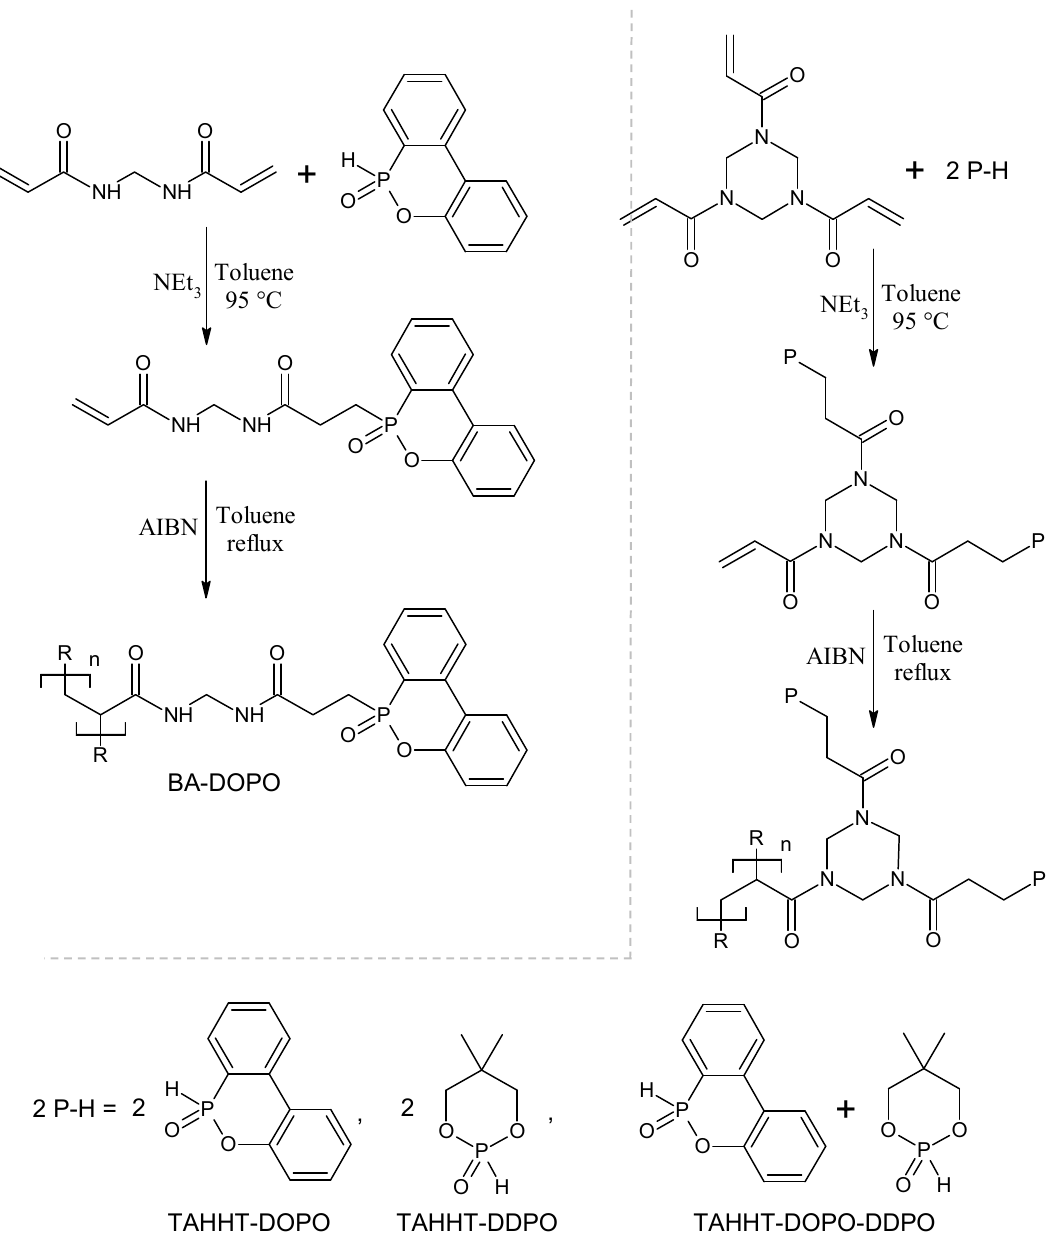
Figure 1. Synthesis of BA-DOPO, TAHHT-DOPO, TAHHT-DDPO and TAHHT-DOPO-DDPO. Detailed ratios are shown in the synthesis descriptions.